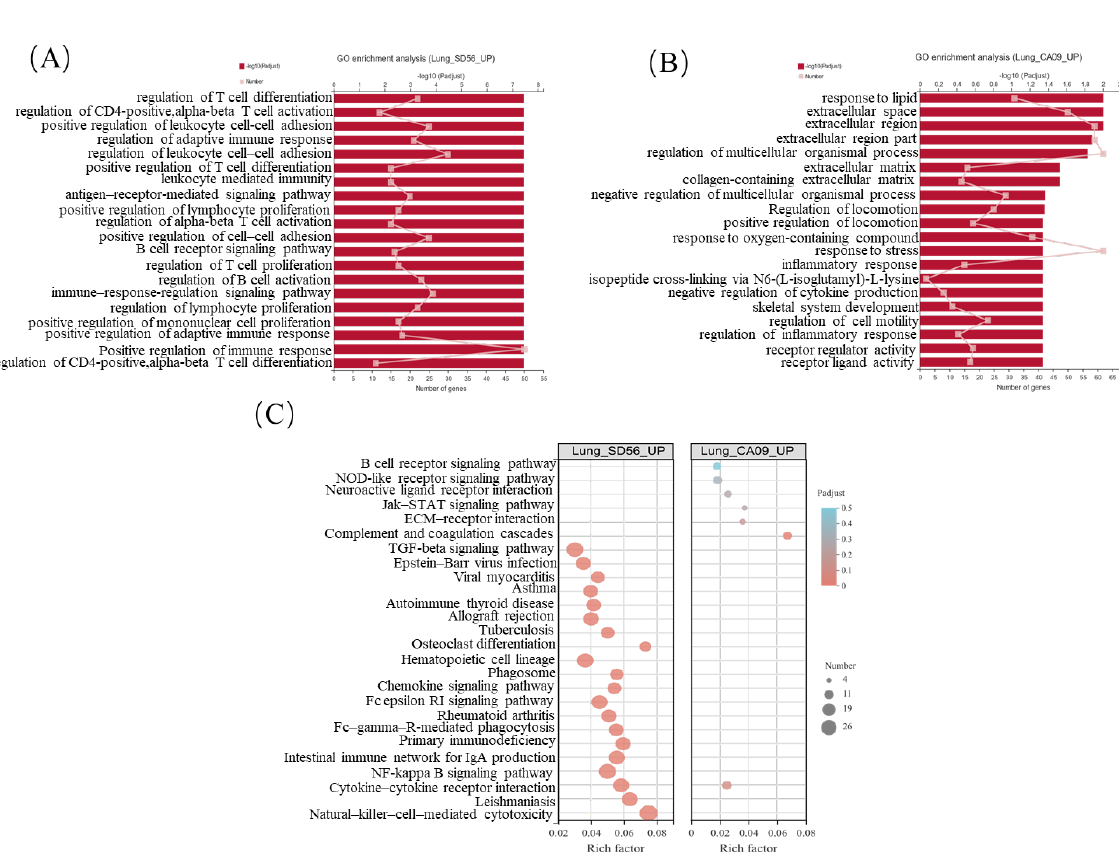
Figure 3. Summary of differentially expressed genes (DEGs) among the CA09 and SD56 infected samples. ( A ) Venn diagram of common lung DEGs when comparing the two groups (con vs. CA09 and con vs. SD56). ( B ) Upset diagram of uniquely DEGs upon CA09 and SD56 infection.